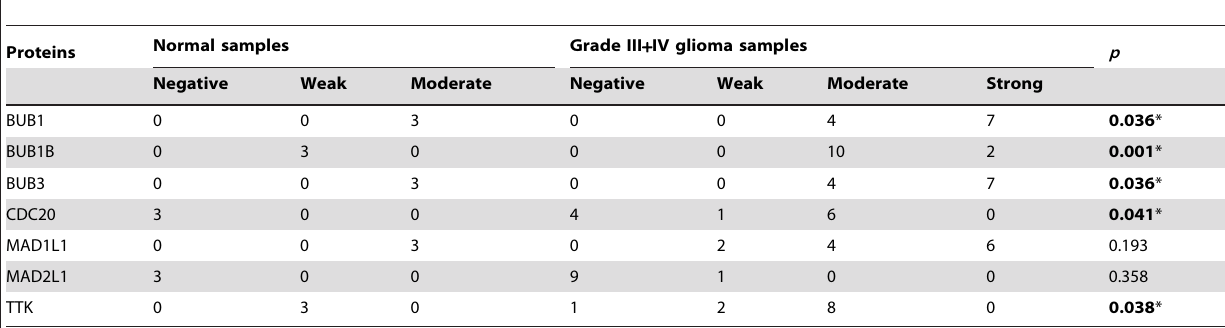
Table 5. Wilcox rank sum test of proteins between normal samples and malignant glioma samples.